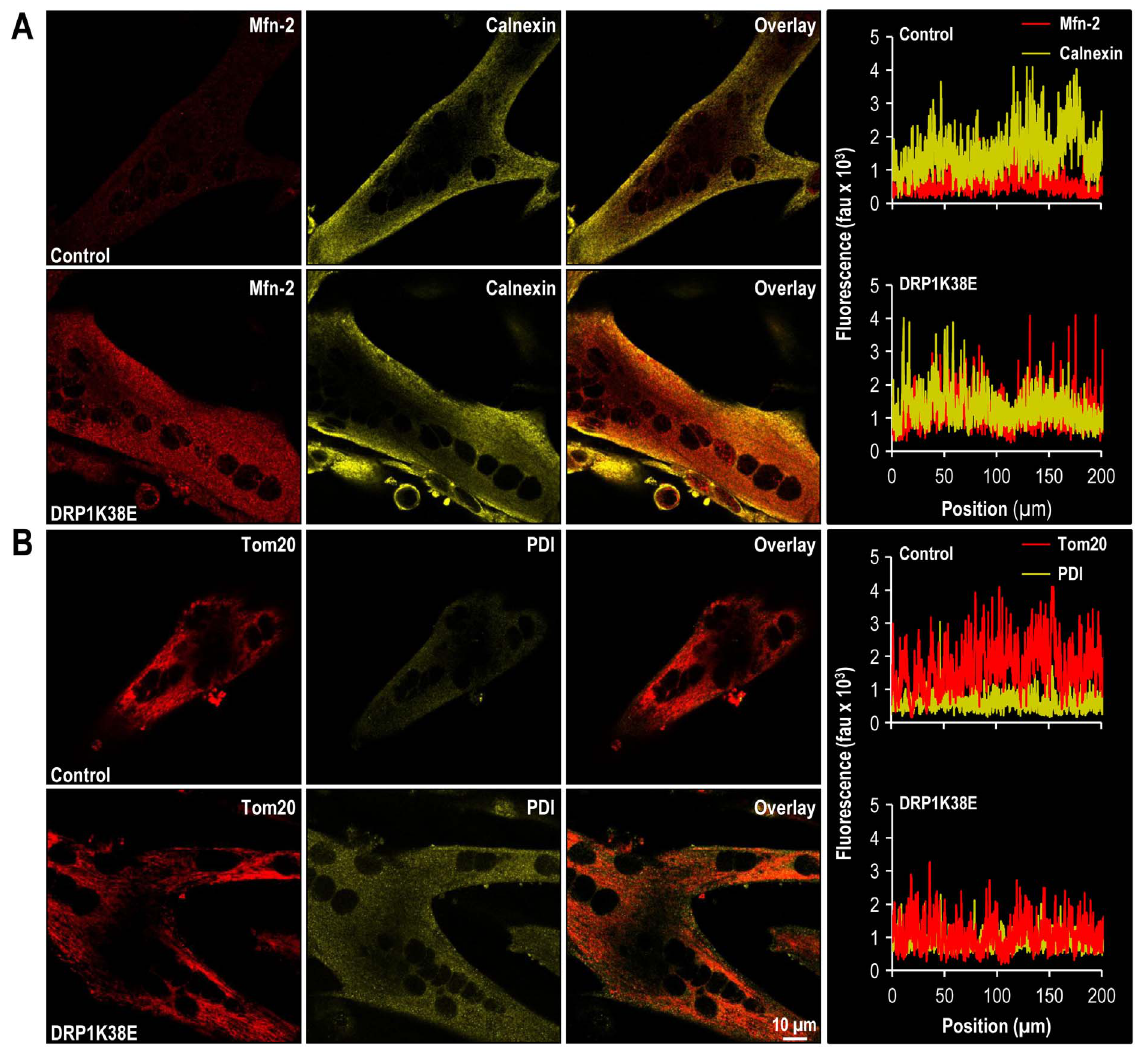
Figure 4. DRP1K38E expression results in a fused mitochondrial reticulum and SR colocalisation in C2C12 myotubes. C2C12 myoblasts were induced to differentiate for 48 h and then were infected with control or DRP1K38E adenoviral vectors for 48 h. Panel A: Confocal images of Mfn-2 and calnexin distribution in differentiated C2C12 myotubes. To illustrate colocalization of mitochondria and ER markers, the corresponding line scans of Mfn-2 and calnexin are drawn on the right. Panel B: Confocal images of Tom20 and PDI distribution in differentiated C2C12 myotubes. To illustrate colocalization of mitochondria and ER markers, the corresponding line scans of Tom20 and PDI are drawn on the right. doi:10.1371/journal.pone.0069165.g004 (Figure 8E ii) and a sevenfold increase in the time to peak (Figure 8E iii) caffeine response (caffeine response time control myotubes 10 6 3 seconds (s) v. 49 6 10 s in NAC myotubes ( p , 0.001 ) and to 67 6 8 s in NAC + BSO treated myotubes ( p , 0.001 ); Time to peak caffeine effect control myotubes 6 6 2 s v. 44 6 12 s in NAC myotubes ( p , 0.001 ) and 43 6 7 s in NAC + BSO treated myotubes ( p , 0.001 ), n= 40 myotubes per group). There